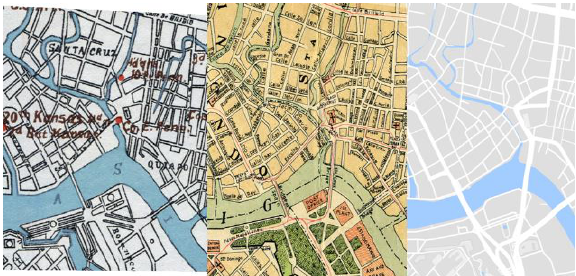
Figure 2. Georeferenced maps of Manila showing a portion of Pasig River and its estuaries: Left - 1899 map courtesy of the Filipinas Heritage Library, Center- 1908 map courtesy of the Filipinas Heritage Library, Right - Google